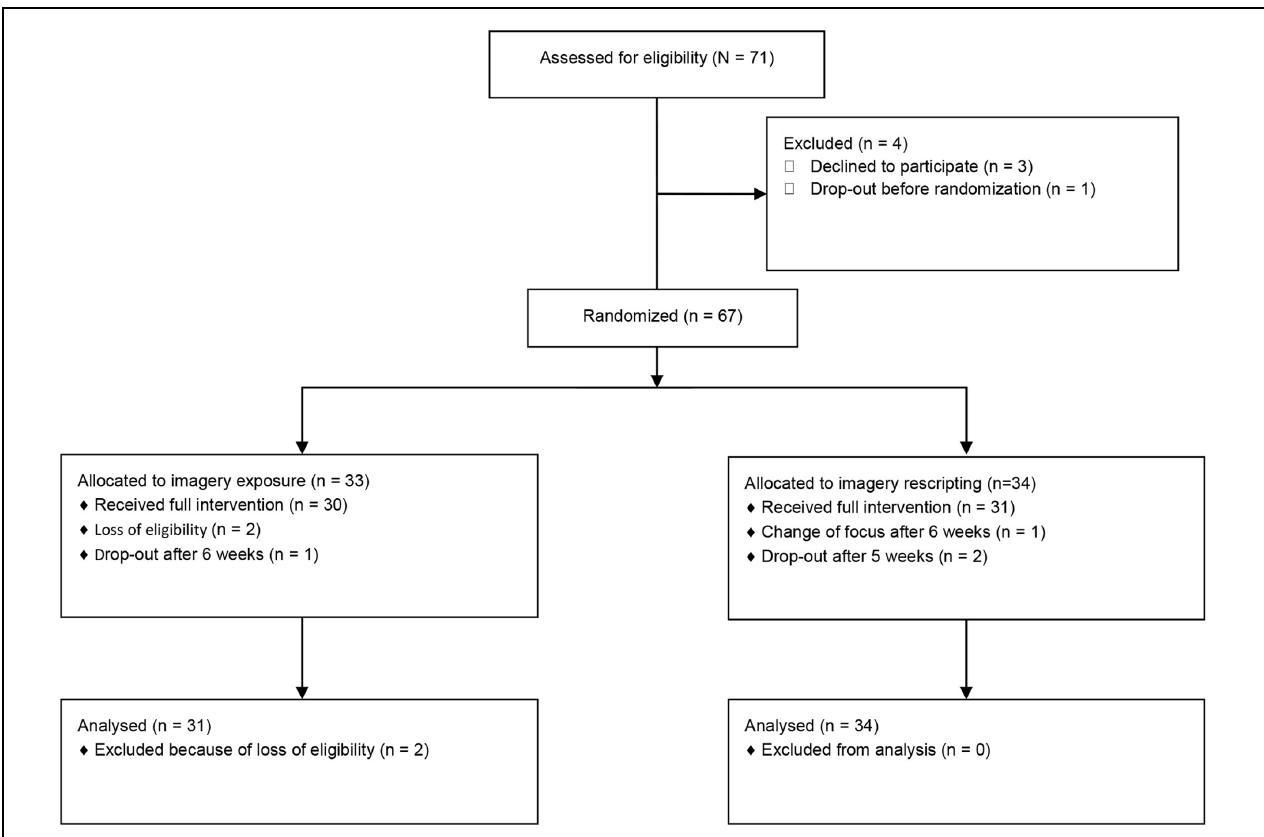
FIGURE 1 | Flowchart of patients included in the